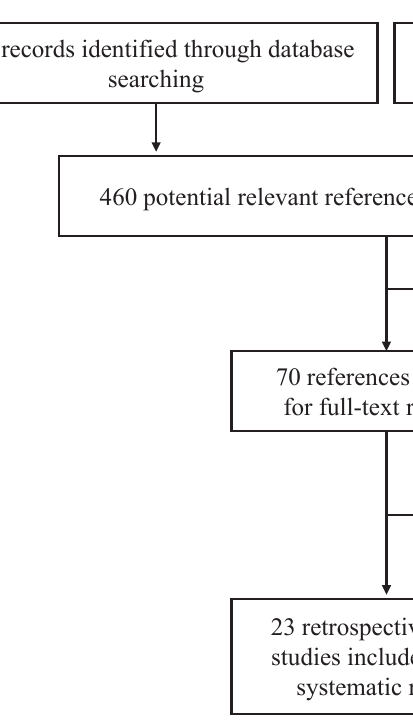
Figure 1. Flow diagram for selection of studies included in the systematic review.